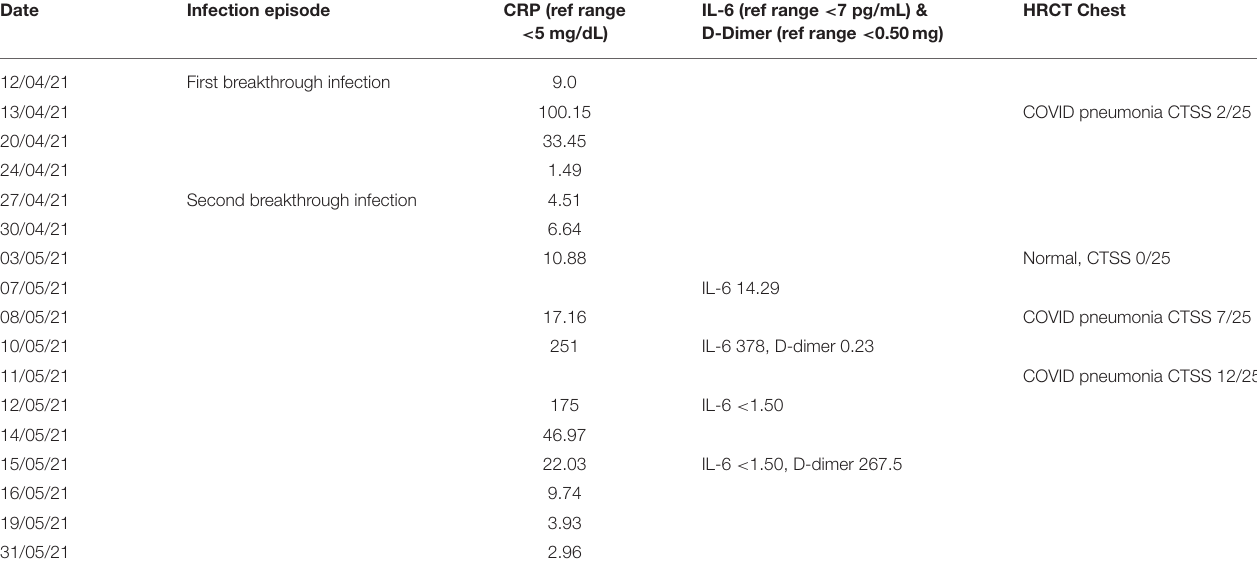
TABLE 2 | Investigations (CRP, IL-6, D-dimer, HRCT